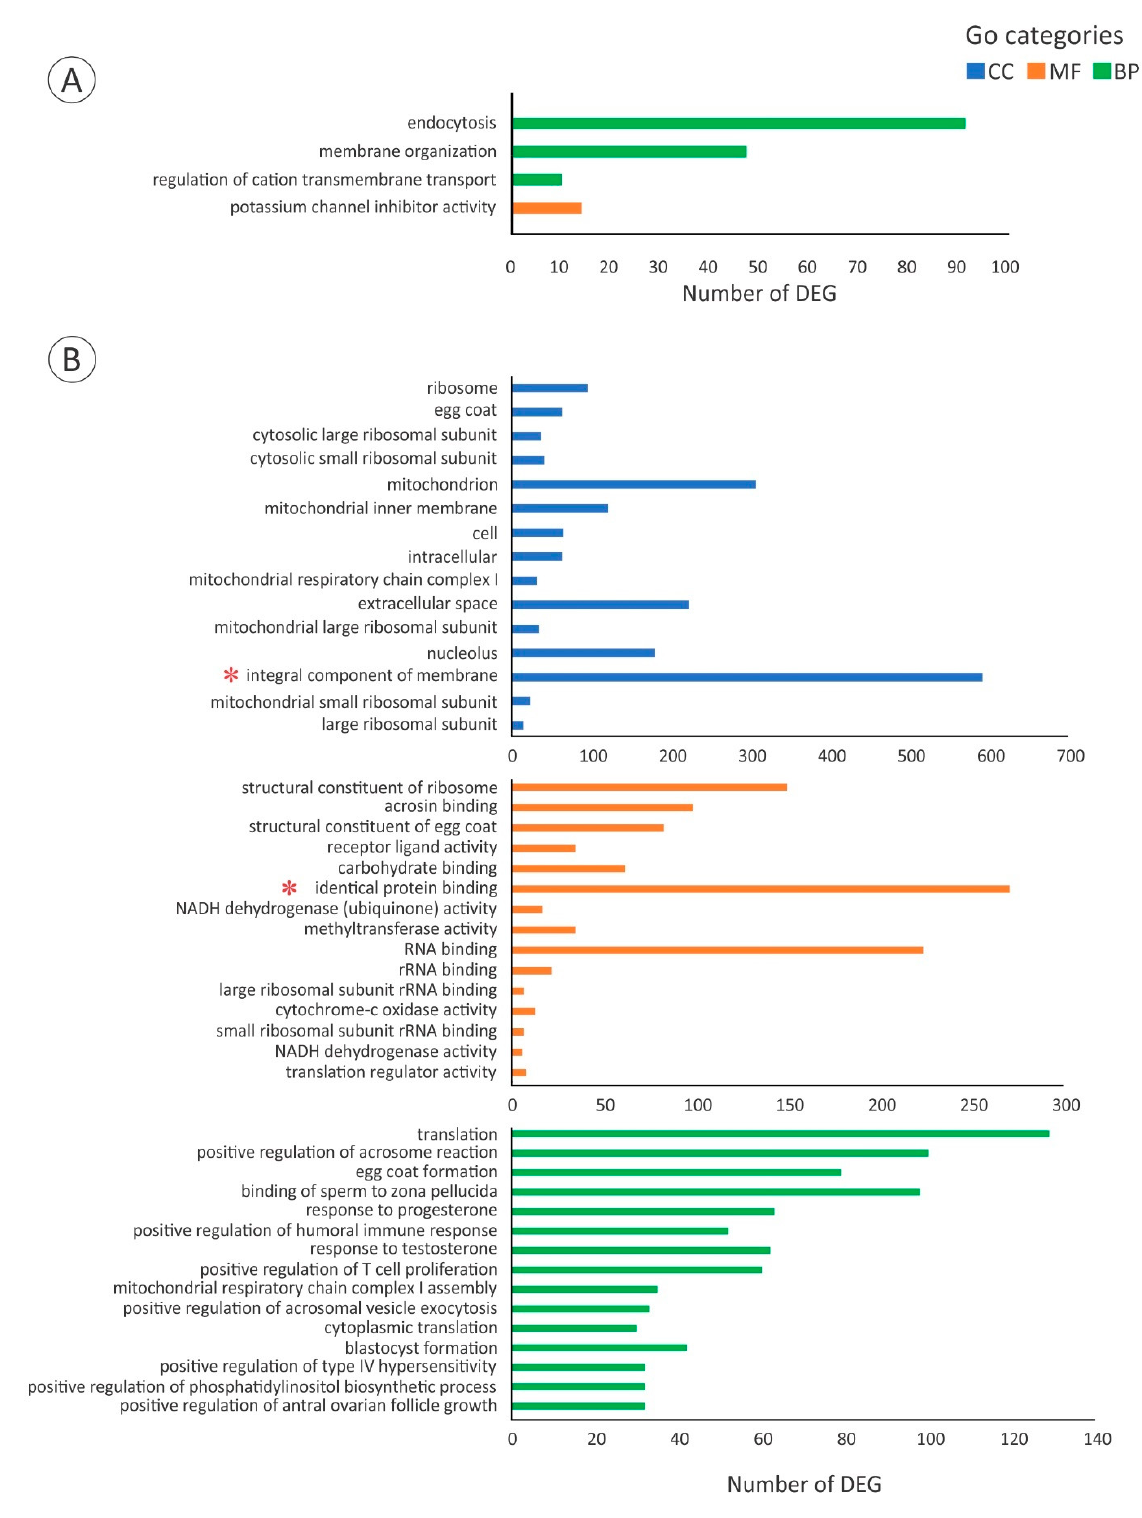
Figure 2. ( A ) All up-regulated GO terms in A. australis ovary when progressing from the PV stage to the EV stage. ( B ) Fifteen most down-regulated GO terms from Biological Process (BP), Molecular function (MF), and Cellular Component (CC) categories during the PV-EV transition. The integral component of membrane and identical protein binding terms are accompanied by a red asterisk.